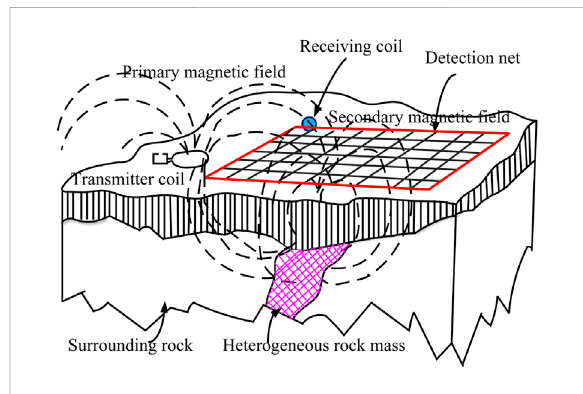
FIGURE 2 The working principle of transient electromagnetic method. FIGURE 3